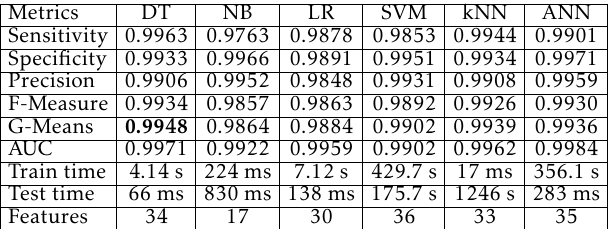
Table 35. Results of using IG-BFE algorithm on GENERIC. Metrics